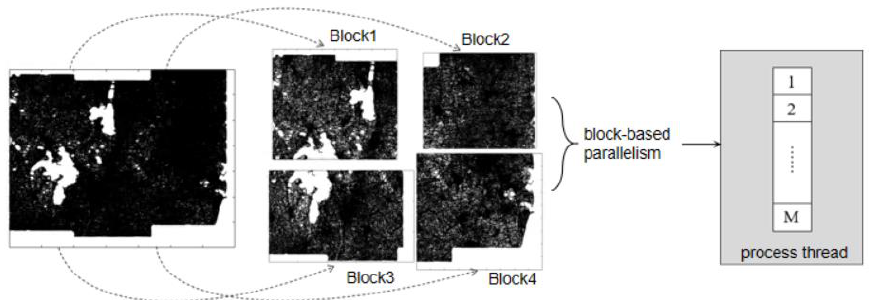
Figure 6. The parallelization strategy for network integration on the block basis.